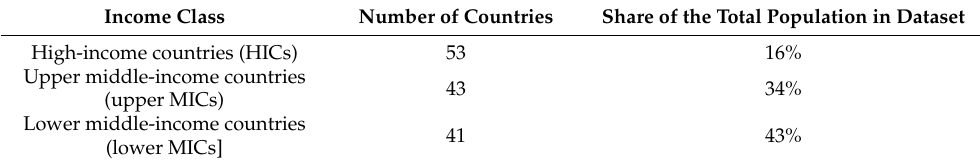
Table A2. Distribution of countries and population across country income groups.